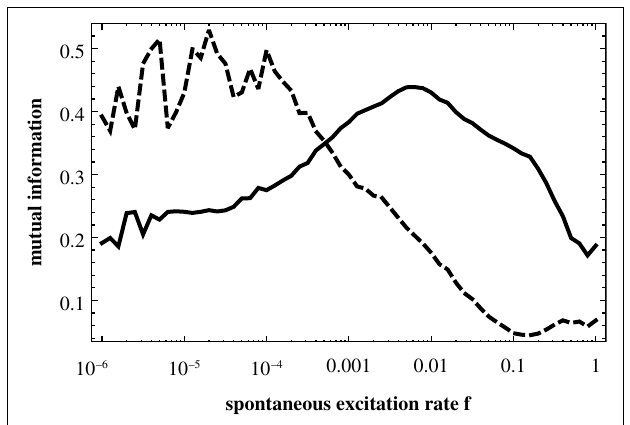
FIGURE 5 | Mean-fi eld excitation density p as a function of the e connectivity c . Dashed curve: prediction of p obtained from the mean-fi eld e model including pair correlations; full curve: results from numerical simulations for Erdös–Rényi (ER) graphs; dotted curve: results from numerical simulations for Barabasi–Albert (BA) scalefree graphs; the general setup of the numerical simulations, including the model graph architectures, is the same as in Müller-Linow et al.